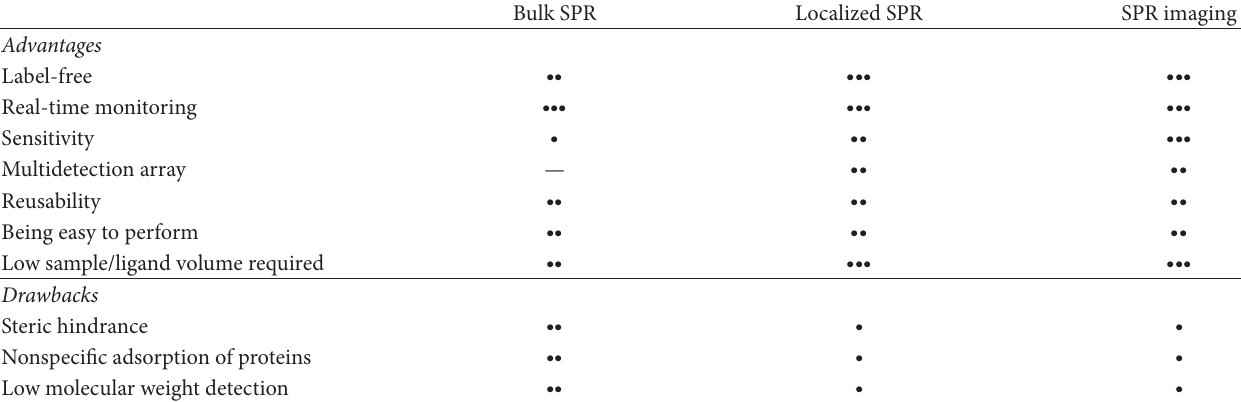
Table 2: Main advantages and drawbacks about bulk SPR, localized SPR, and SPR imaging transduction in